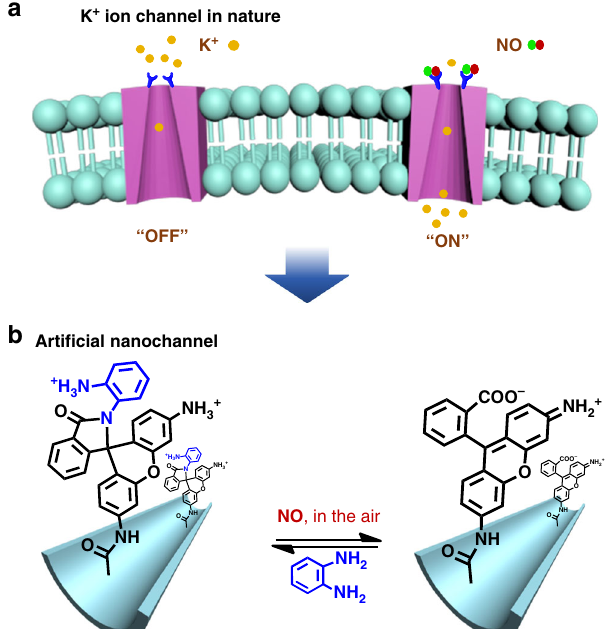
Fig. 1 Schematic depiction of the ion channels. a NO-responsive ion channel in nature. b Scheme of the design of an NO-responsive nanochannel using